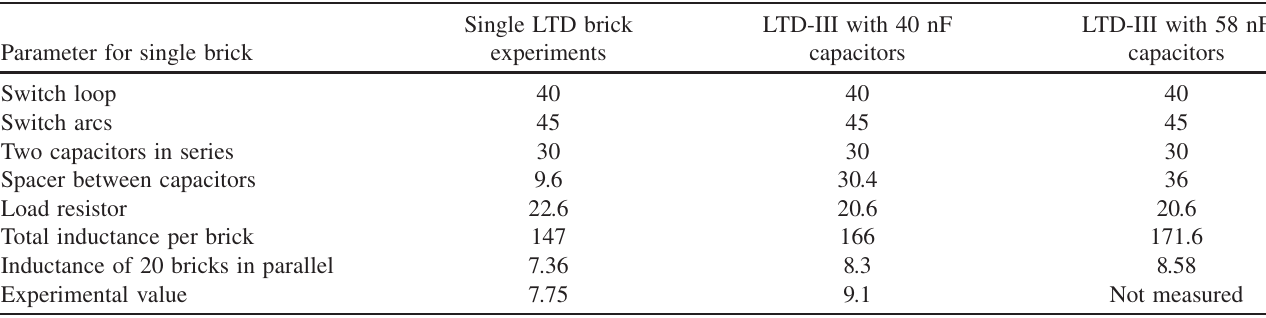
TABLE II. Inductance of components in LTD systems. All inductances are in nano-Henries. Parameter for single brick